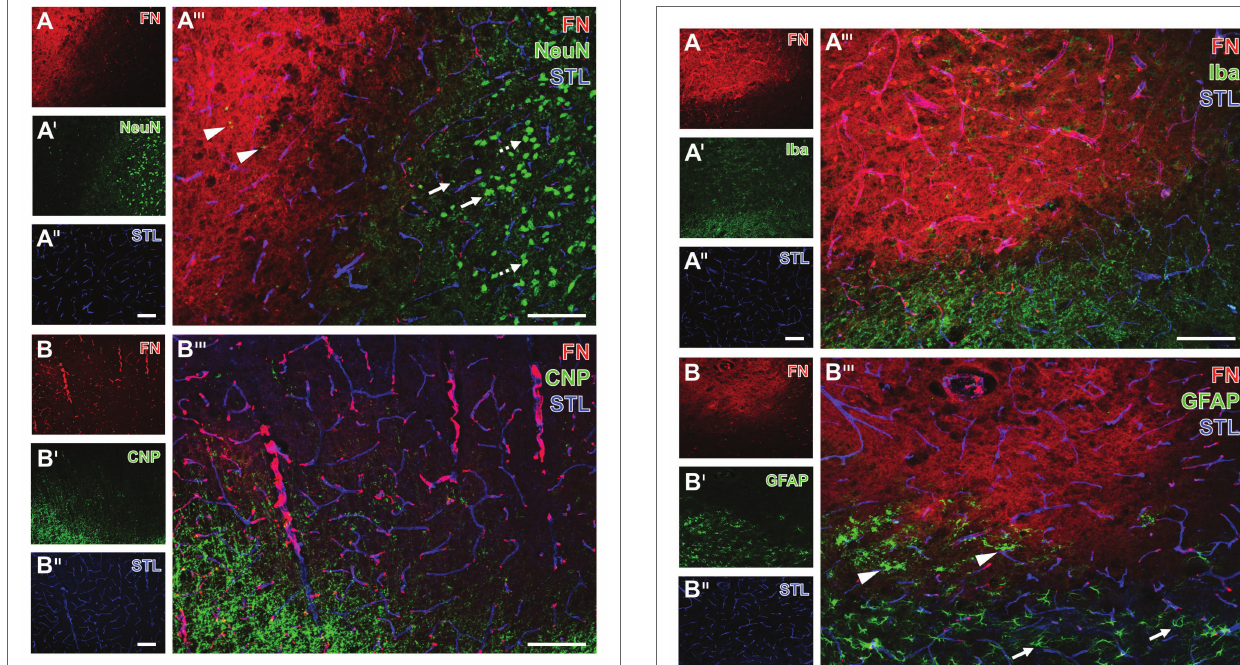
FIGURE 6 | Spatial relationships between fibronectin, the vasculature, microglia, and astrocytes in mice subjected to 24 h of experimental focal cerebral ischemia. Staining of fibronectin (FN, A,B ) together with the lectin- based visualization of the endothelium by STL (A '' ,B '' ) and Iba (A ' ) as marker for microglia indicate a mainly morphological alteration of the latter one in the ischemia-affected striatum. Toward the area of ischemia an increase of the FN signal is visible (A) in addition to nearly unaltered detection of vessels (A '' ) . GFAP immunolabeling displays a loss of astrocytes in the striatum as the region of maximum ischemic affection (B ' ) with a simultaneous increase of the FN signal (B) . In the ischemic border zone, astrocytes are morphologically altered (arrow heads in B ''' ) when compared to their regular appearance (arrows in B ''' ). Scale bars: in A ''' and B ''' = 100 μ m, in A '' (also valid for A and A ' ) and B '' (also valid for B and B ' ) = 100 μ